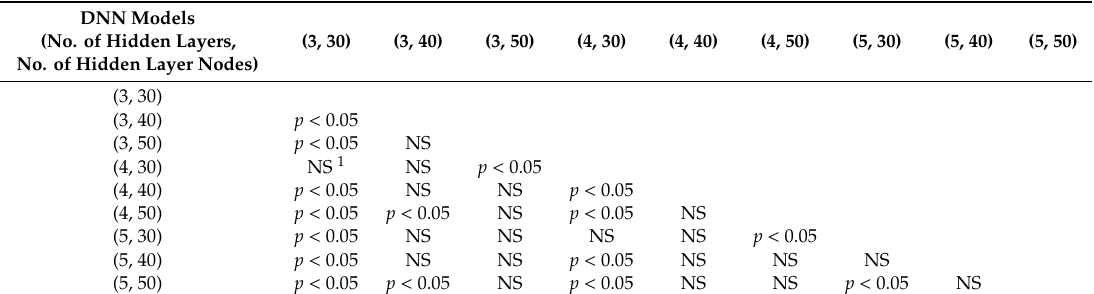
Table 7. Results of t-significance test for DNN models for predicting morning ore production with di ff erent hidden layer configurations. DNN Models (No. of Hidden Layers, No. of Hidden Layer